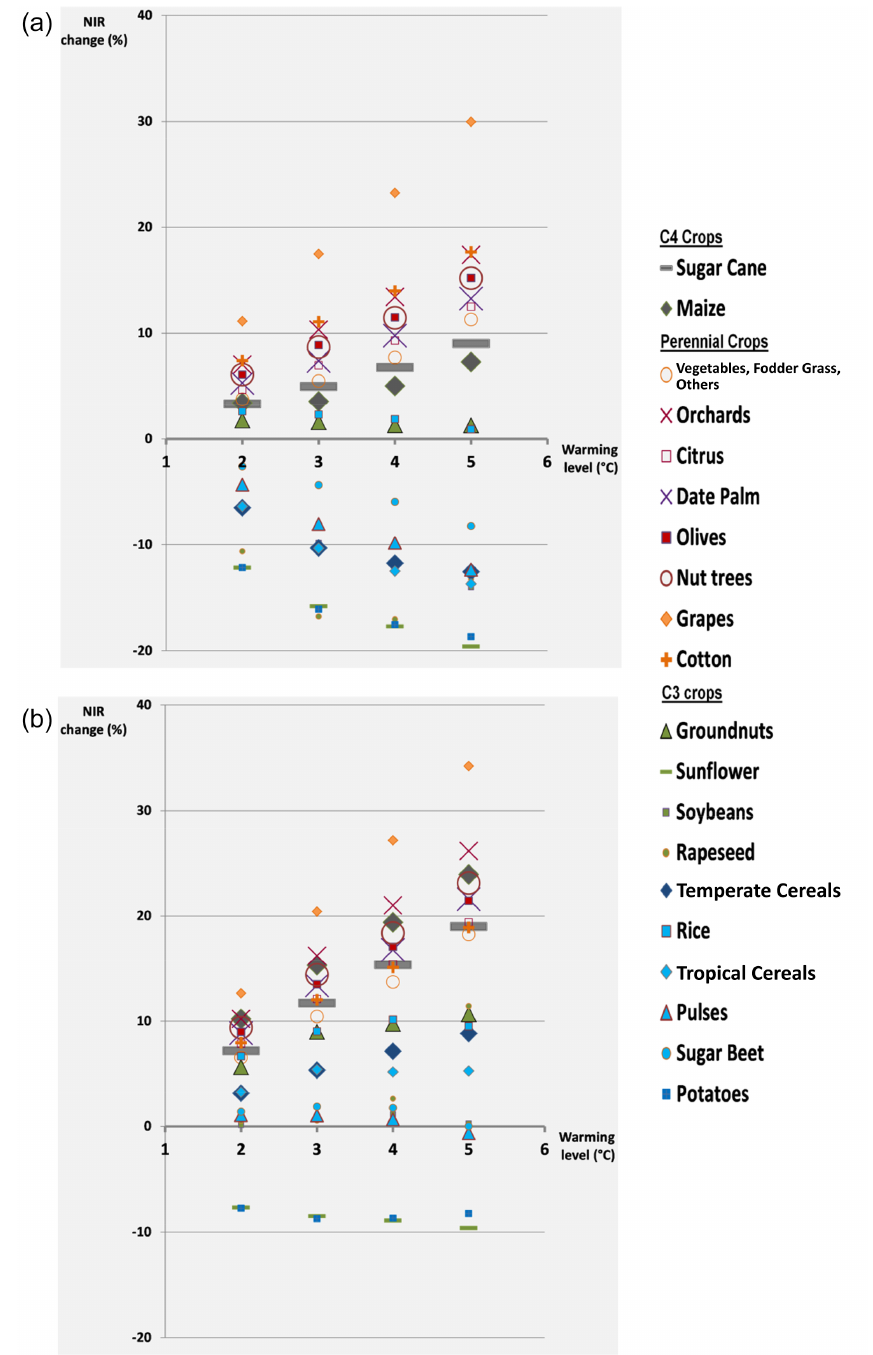
Figure 6. Change in per unit of net area irrigation water requirements (NIR) from 2000–2009 to 2080–2090 for different crop classes and the DYN (a) and CONST (b) CO 2 -fertilization scenario. Negative (positive) values indicate a decrease (increase) in NIR (see Fig. S8 for the RED